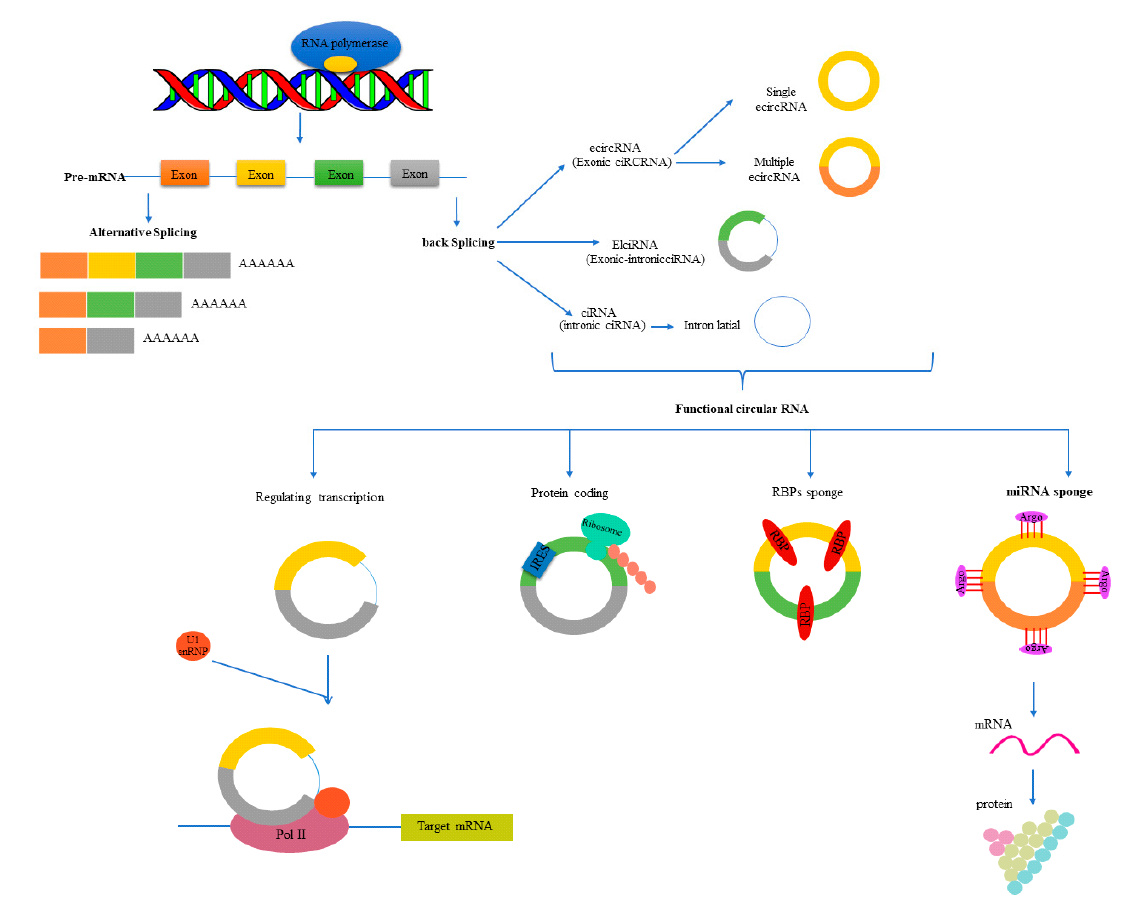
Figure 2. The image illustrates the classification and function of circRNAs.